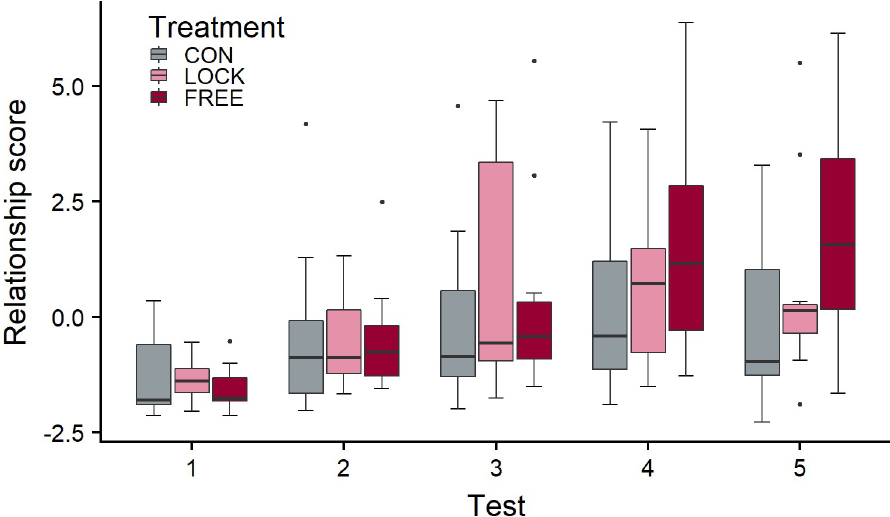
Fig 3. The relationship score in the three treatment groups over the course of the study. The FREE group experienced gentle interactions with a person while free in the barn, the LOCK group while restrained in the feeding rack; the CON group did not experience gentle interactions. The treatment period comprised 6 weeks with a total of 30 treatment days between tests 1 and 4; during the 2 weeks between tests 4 and 5, no treatment took place. LMM: test number p = 0.008, test number × treatment p = 0.014; n = 12 per treatment group and test number, except for test 1 n CON = 11, test 3 n LOCK = 10, test 4 n LOCK = 11, test 5 n LOCK = 11.